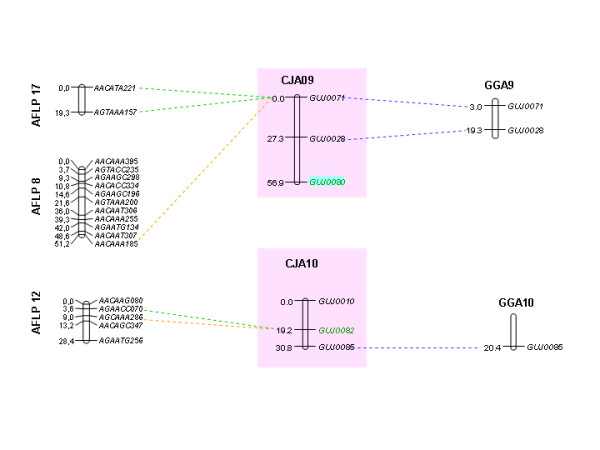
Alignments of Japanese quail microsatellite and AFLP maps and links to the assembled chicken sequence. Left: AFLP linkage groups from [14]; center: integrated microsatellite and gene map (this study); right: chicken February 2004 sequence assembly [22]. AFLP and microsatellite genetic maps are in cM and the sequence assembly is in Mb. New quail linkage groups have blue titles and new microsatellite and gene markers are in green. Genes are in boldface italic. Microsatellite markers informative in both species are in red boxes. Chicken markers have a yellow background. Quail microsatellites or genes with similarity to chicken sequence of unknown location (chrun) have a blue background. Dotted lines linking the microsatellite and the AFLP maps indicate positive results of two-point linkage between the markers, with supporting LOD scores of 3 to 6 (green), 6 to 10 (orange) or more than 10 (red).